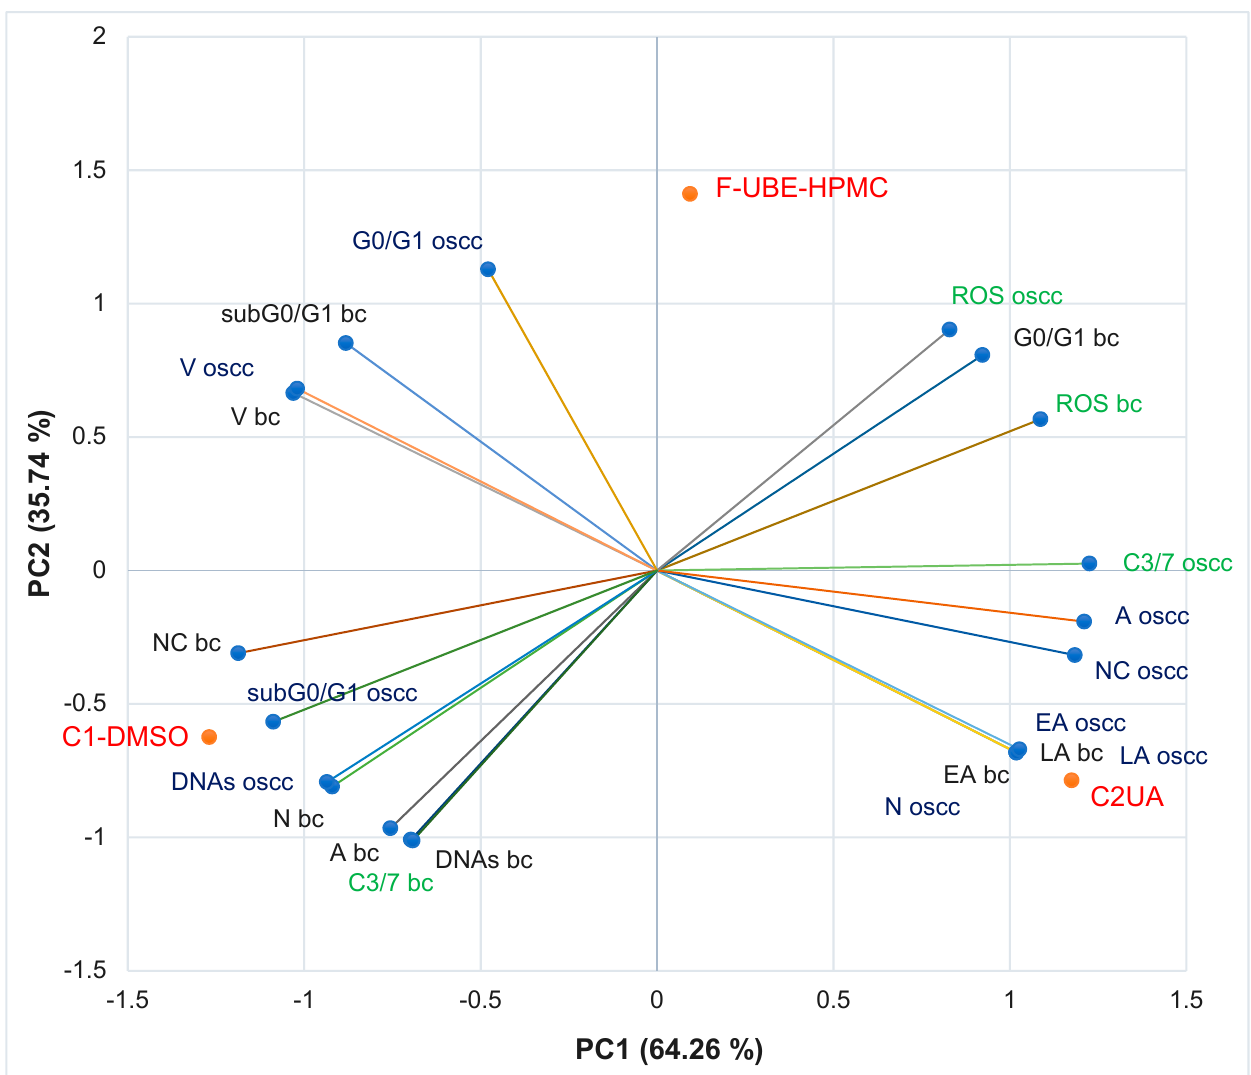
Figure 10. PCA-Correlation biplot between mechanisms (caspase 3/7 activity and cellular oxidative stress) and processes induced by F-UBE-HPMC and both controls (C1-DMSO and C2UA) in normal blood cells (bc) and CLS-354 tumor cells (oscc). F-UBE-HPMC—mucoadhesive oral patches loaded